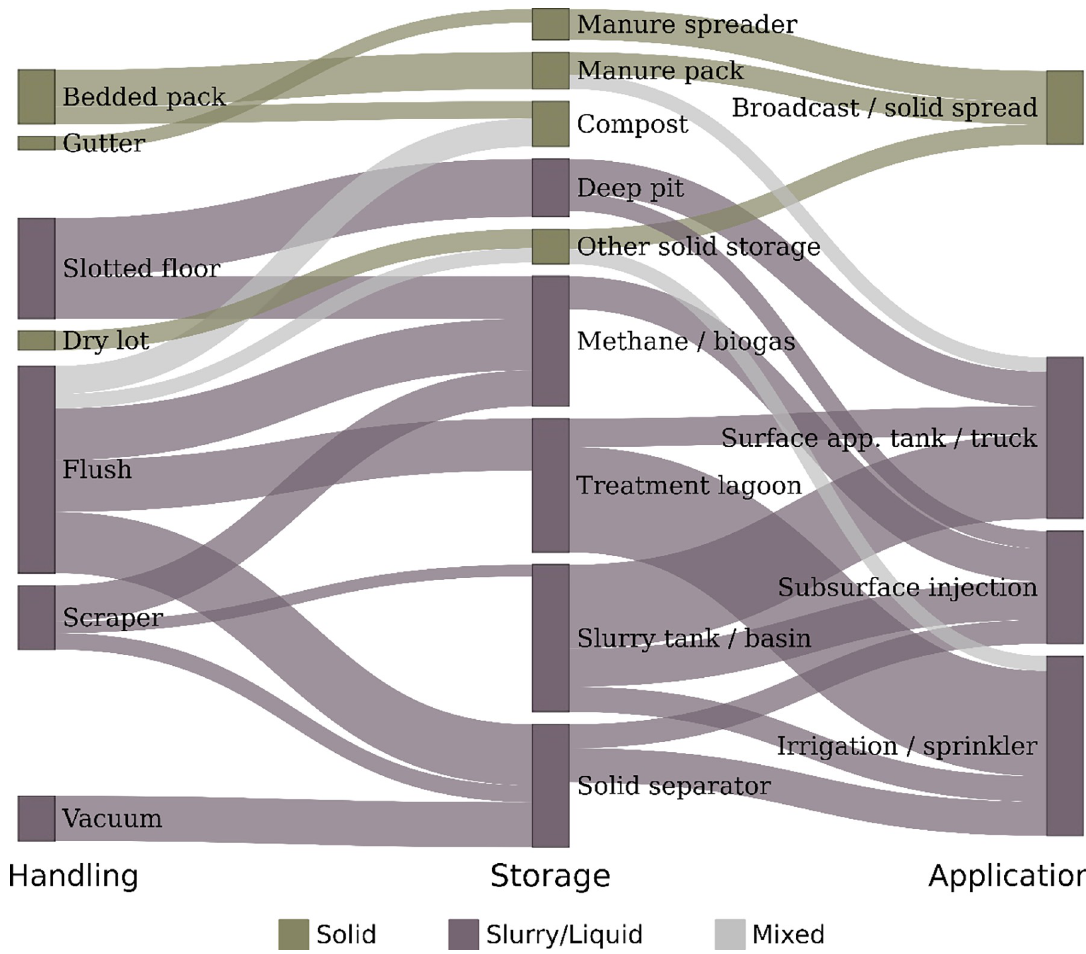
Fig 8. Sankey-style diagram showing connections between MMS, based on logit model results. Only models with OR > 1, and with family-wise p < 0.05 are included. Width of link increases with higher OR. Nodes and links are color coded according to their classification as elements commonly used in a solid, slurry/liquid, or mixed